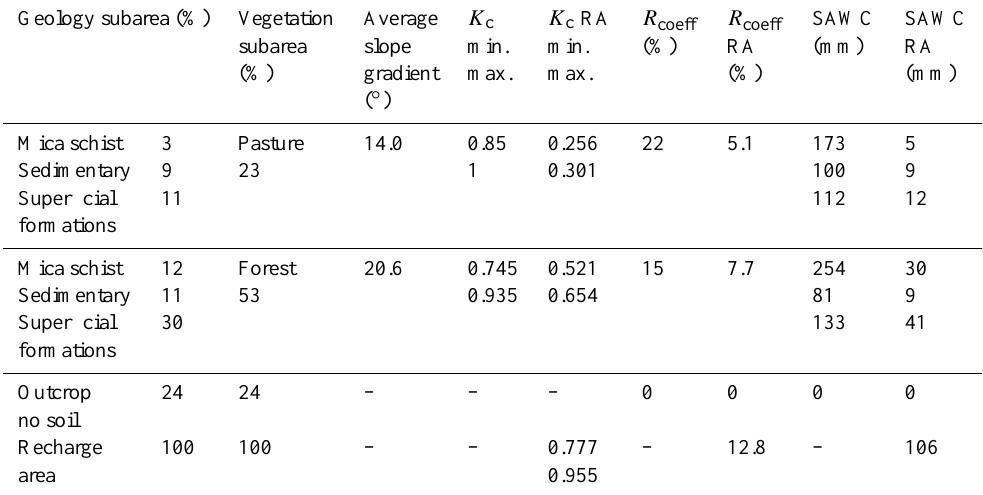
Table 4. Estimation of K c , SAWC and runoff for the recharge area of the Séchilienne landslide. Geology and vegetation are the subarea factors identified and expressed in relative proportion of the recharge area. The average slope gradient is the slope gradient for each identified vegetation subarea factor. K c , R coeff and SAWC columns are the estimated values for each subarea factor. K c RA, SAWC RA and R coeff RA columns are the contribution of each subarea parameter at the scale of the recharge area. The recharge area (bottom row) stands for the estimation at the scale of the recharge area. Geology subarea (%) Vegetation